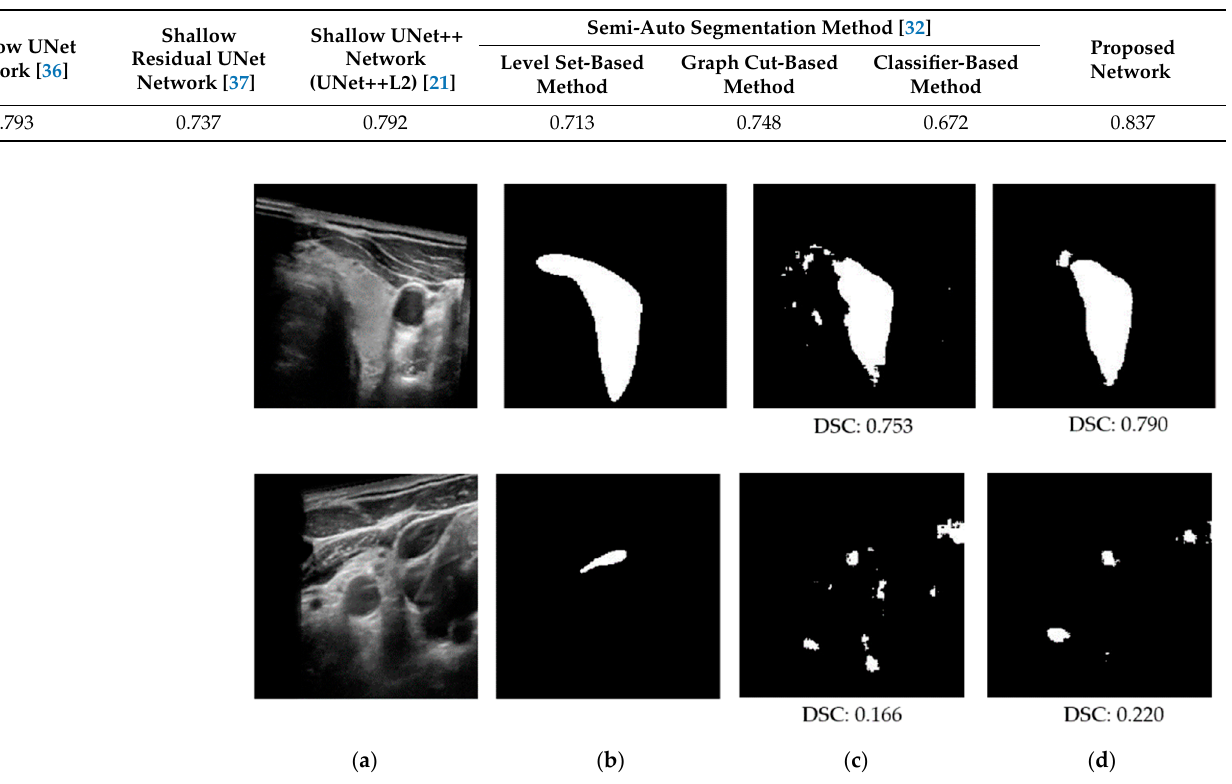
Table 9. Comparison of segmentation performance (DSC) between our proposed method and previous study on 3DThyroid dataset.